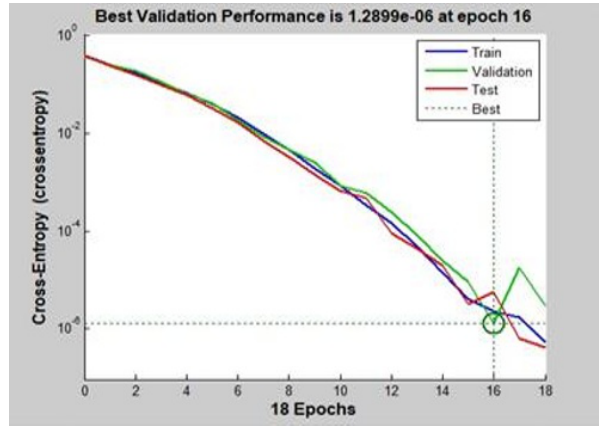
Fig 8 : Performance Plot The current progress or status of the training at a specific time while training is in progress gives the training state. We have given 6 validation errors,hence the training will stop as soon as 6 validation errors occurs.